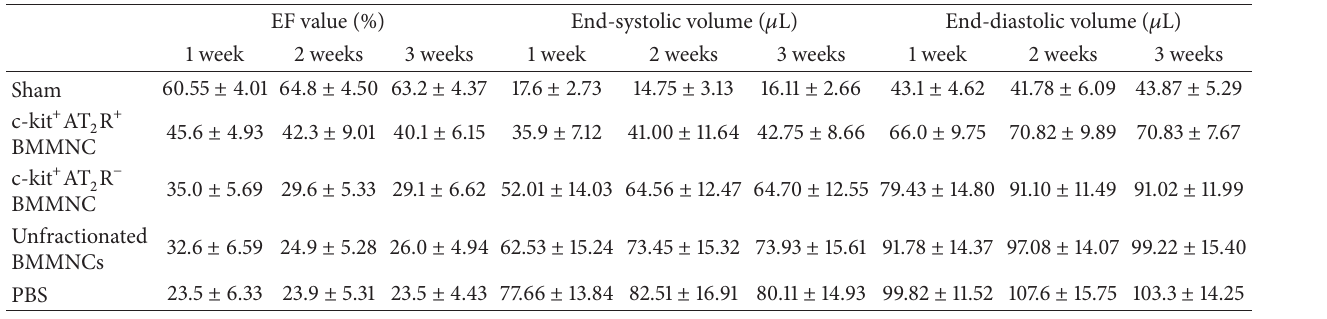
Figure 4: Transwell migration assay of cell subsets derived from mice BMMNCs. (a) A schematic picture of transwell migration assay. (b) Statistical analysis of migrated cell numbers ( ∗ 𝑝 < 0.05, ∗∗ 𝑝 < 0.01; values are means ± SEM; 𝑛 = 5). Table 2: Echocardiography